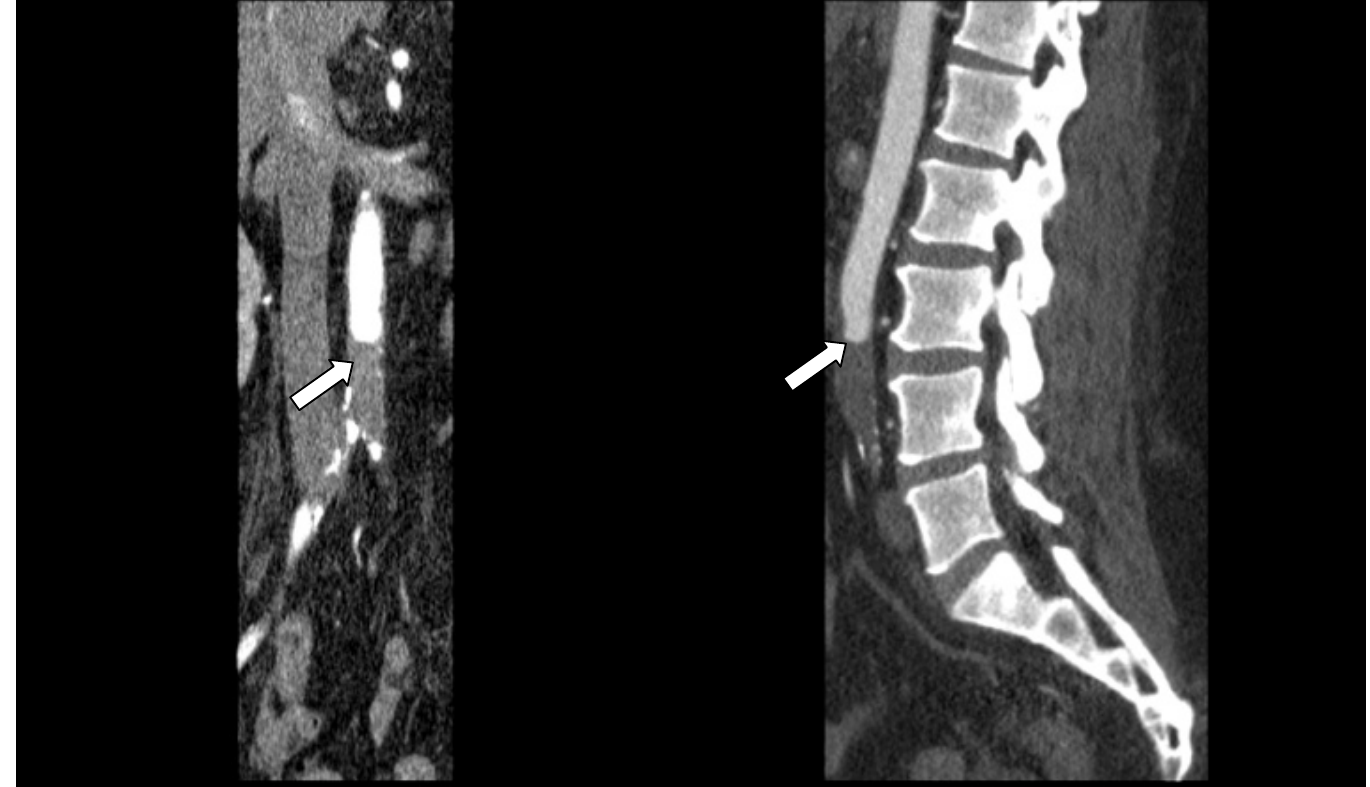
Figure. Computed tomography angiography of the thorax and abdomen shows a complete thrombosis of the distal aorta below the inferior mesenteric artery, extending to the common iliac